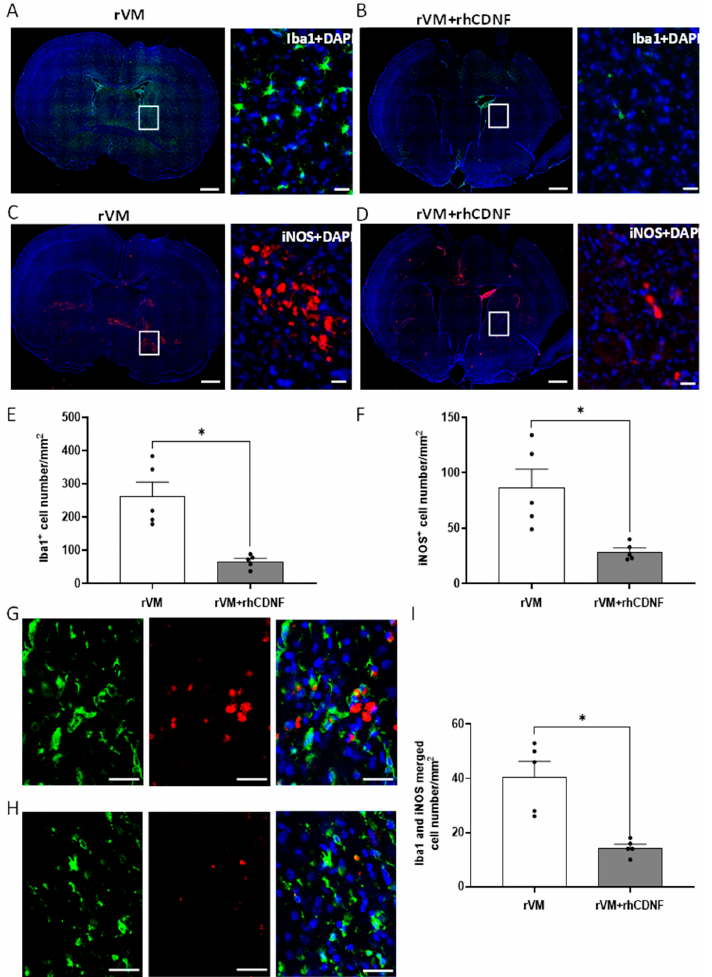
Figure 7. Distribution of microglia/macrophage marker, Iba1, and inflammatory marker in the grafted striatum at four weeks after transplantation. ( A , B ) Representative images of grafted striatum sections immunostained with Iba1 and counterstained with DAPI (blue). In the rVM group, there is a large number of Iba1 − positive cells in the grafted striatum ( A ), while less Iba1 − postive staining was found in the corresponding area of rVM + rhCDNF group ( B ). The right column, representation of panel in left column, shows microglia/macrophage in higher magnification stained with Iba1. Scale bar = 1000 μ m in left column of each group. Scale bar = 20 μ m in right column of each group. ( C , D ) Representative images of grafted striatum immunostained with iNOS. The insets show cells in higher magnification stained with iNOS antibody. Less iNOS-positive staining was found in the grafted striatum of rVM + rhCDNF ( D ) compared to rVM group ( D ). Scale bar = 1000 µ m in left column of each group. Scale bar = 20 µ m in right column of each group. ( E ) Quantitation of Iba1-positive cells in the grafted striatum at 4 weeks after transplantation showing accumulation of microglia/macrophages in rVM group. In the rVM + rhCDNF group, there is a significant de- crease in Iba1 − postive microglia/macrophage density in the corresponding area. ( F ) Quantitation of iNOS − positive cells in the grafted striatum at 4 weeks after transplantation showing accumu- lation of inflammatory cells in rVM group. In the rVM + rhCDNF group, there is a significant decrease in iNOS-positive immune cell density in the corresponding area. ( G , H ) Section of grafted striatum at 4 weeks after transplantation double-stained with Iba1 (green) and iNOS (red). rVM + rhCDNF group ( G ) showed fewer Iba1 − and iNOS − positive cells compared with the rVM group ( H ). Scale bar = 20 µ m. ( I ) Quantification of Ib1 − and iNOS − positive cell numbers * p < 0.05 indicates comparison with rVM group with Student’s t -test. The data represent mean ±